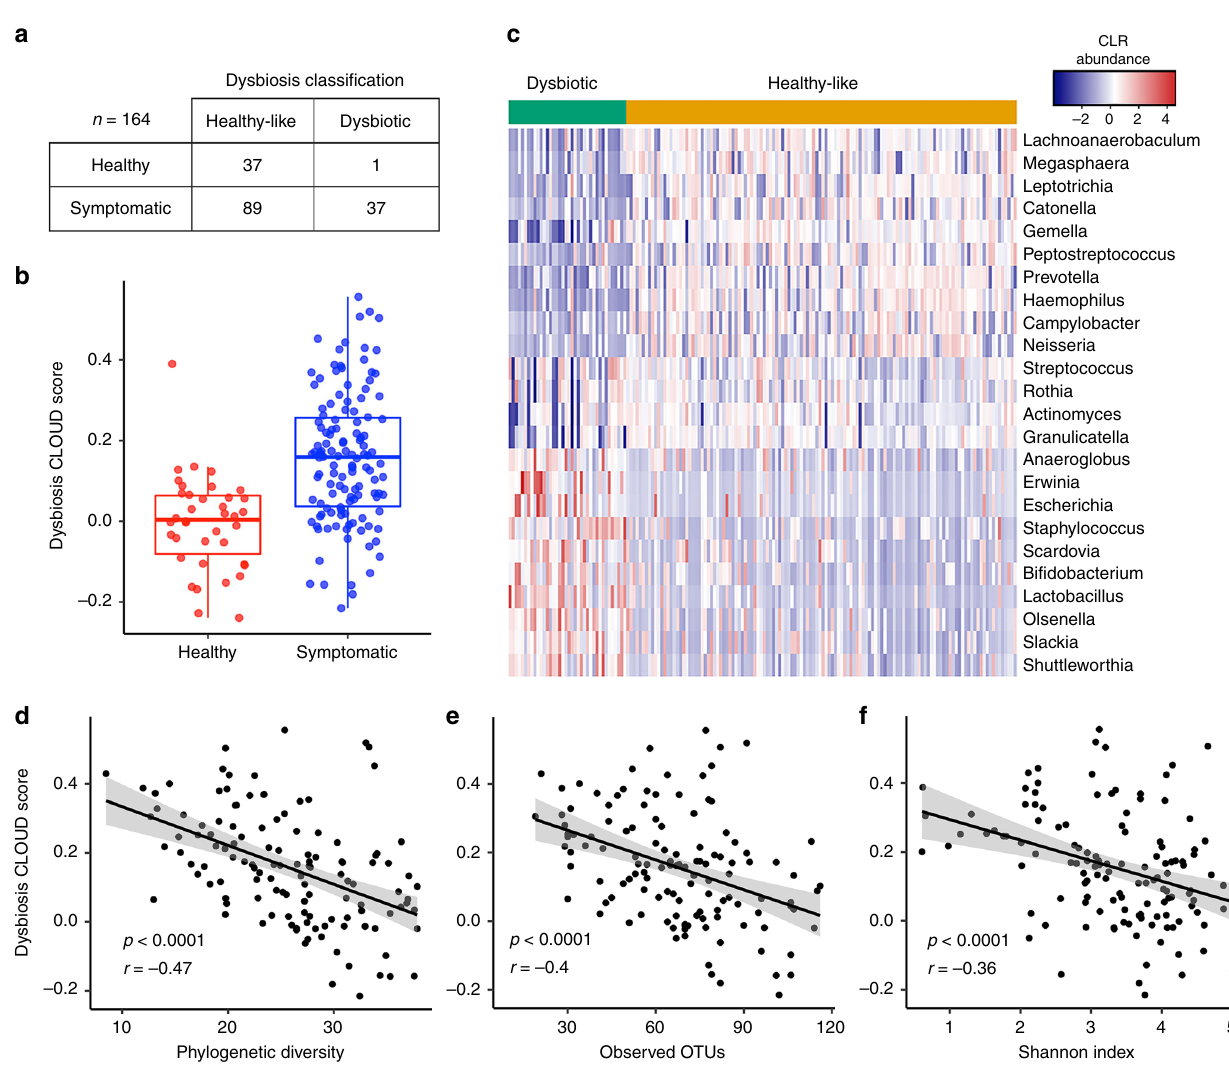
Fig. 3 Dysbiosis index identi fi es a subset of symptomatic patients with altered microbial communities. a Classi fi cation of healthy and symptomatic patients as dysbiotic or healthy-like based on the CLOUD test, which evaluates each sample by its distance to healthy controls ’ microbiome distribution. b The log- transformed CLOUD statistic for samples (or dysbiosis index (DI)) from healthy controls ( n = 38, red) and symptomatic patients ( n = 126, blue). Tukey boxplots show the median with IQR and 1.5 IQR whiskers. c Heatmap of signi fi cantly different genus-level taxa from healthy control and symptomatic patients that contribute signi fi cantly to the DI identi fi ed using Boruta feature selection from the random forest model 40 . Samples classi fi ed as dysbiotic or healthy-like are indicated at the top by orange and green, respectively. Pearson correlation of DI with alpha diversity based on d phylogenetic diversity ( p < 0.0001, r = − 0.47, Pearson correlation), e observed OTUs ( p < 0.0001, r = − 0.4, Pearson correlation), f Shannon index ( p < 0.0001, r = − 0.36,